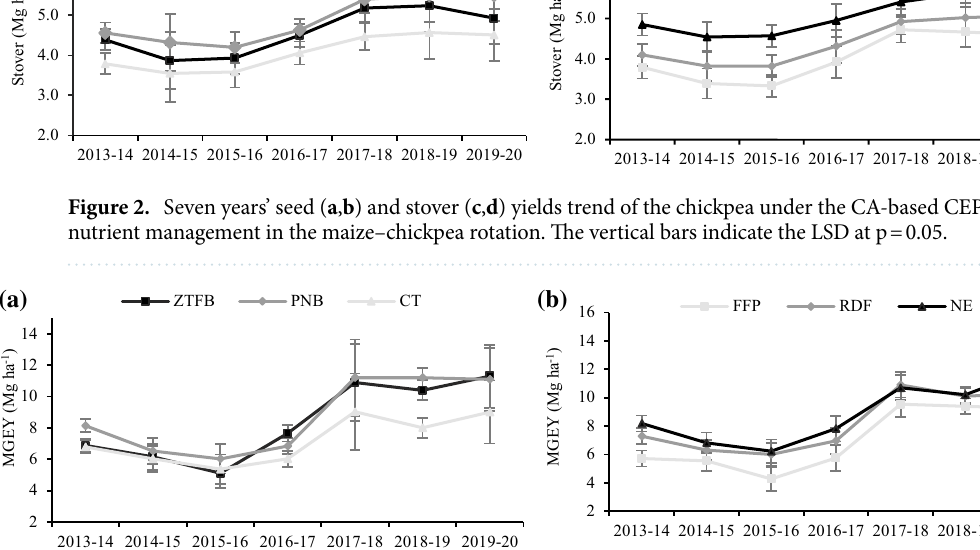
Figure 3. Seven years’ trend in the MGEY ( a , b ) under the CA-based CET and nutrient management in the maize–chickpea rotation. The vertical bars indicate the LSD at p = 0.05.